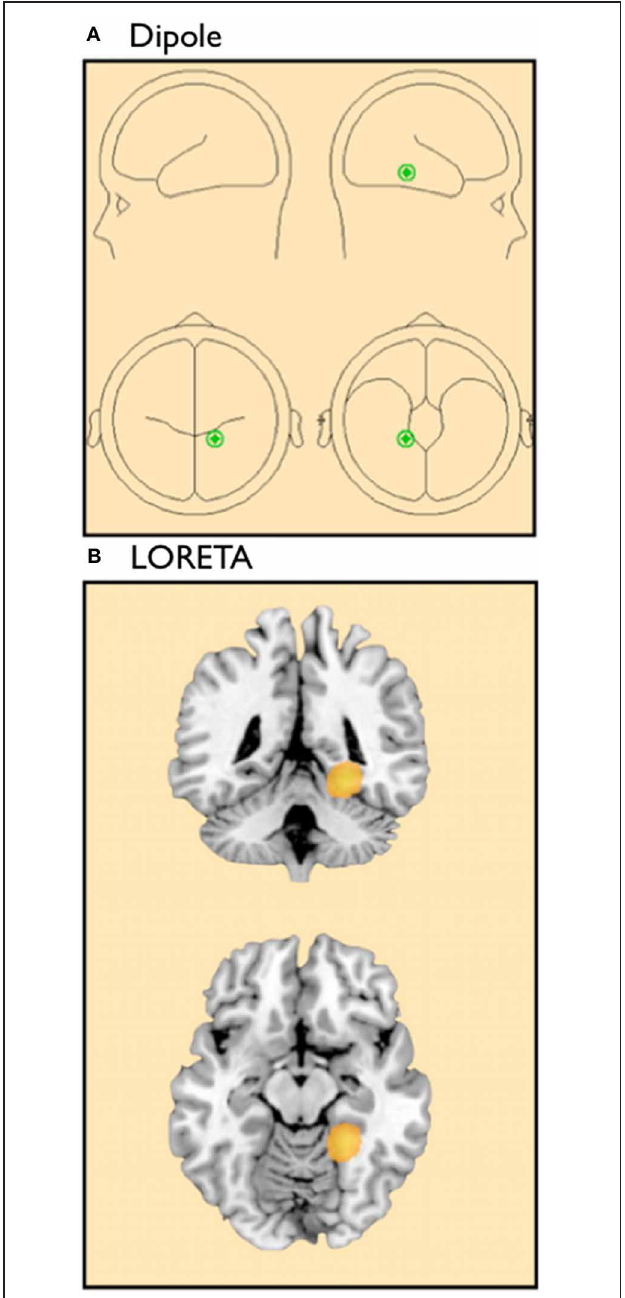
FIGURE 1 | (A) Localization of BESA Dipole modeling for latent variable. (B) LORETA source modeling result for latent